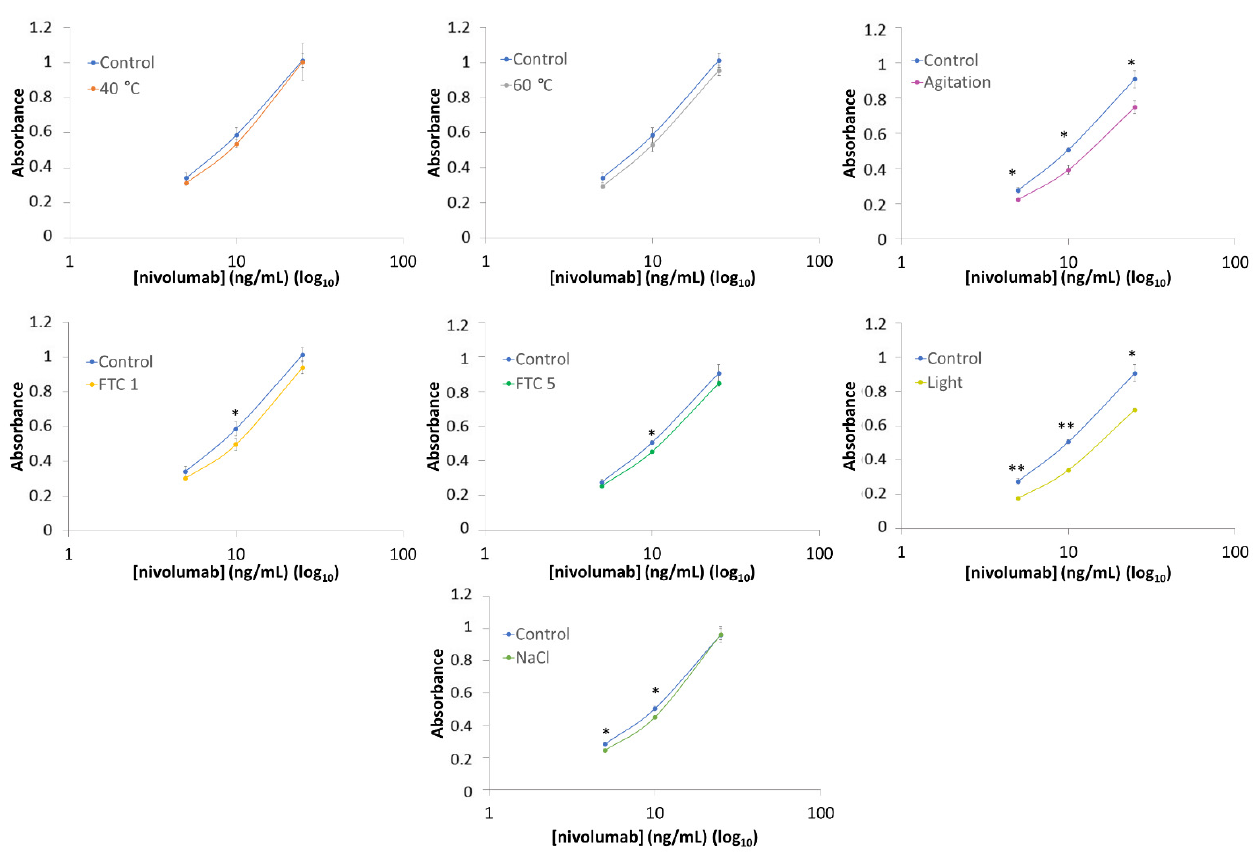
Figure 6. ELISA binding assay (5, 10 and 25 ng/mL) for the stressed samples as compared to a fresh (control) sample of nivolumab (*: p -value < 0.05; **: p -value < 0.001).